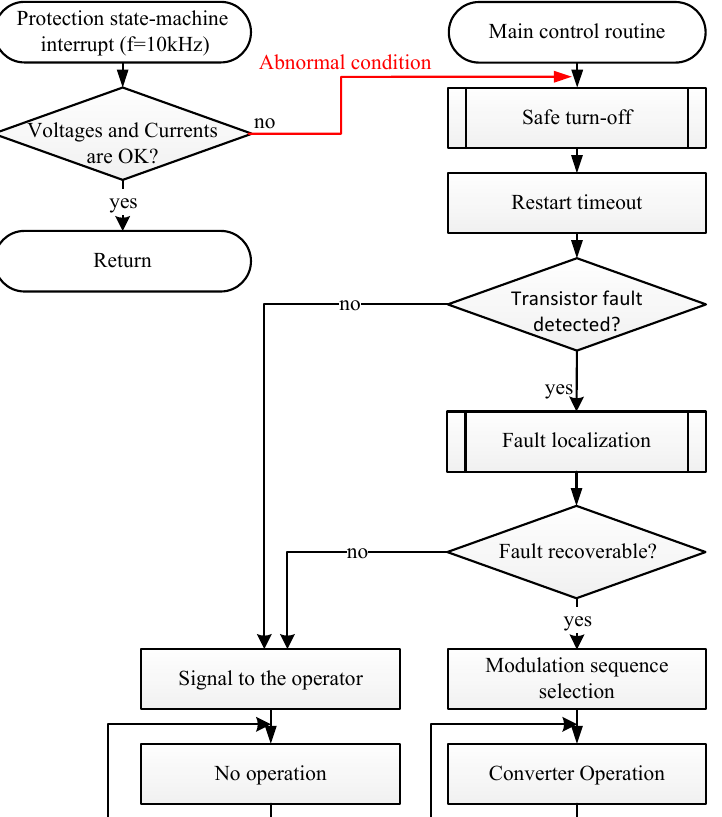
Figure 2. Generalized fault detection procedure for the case study current source converter.